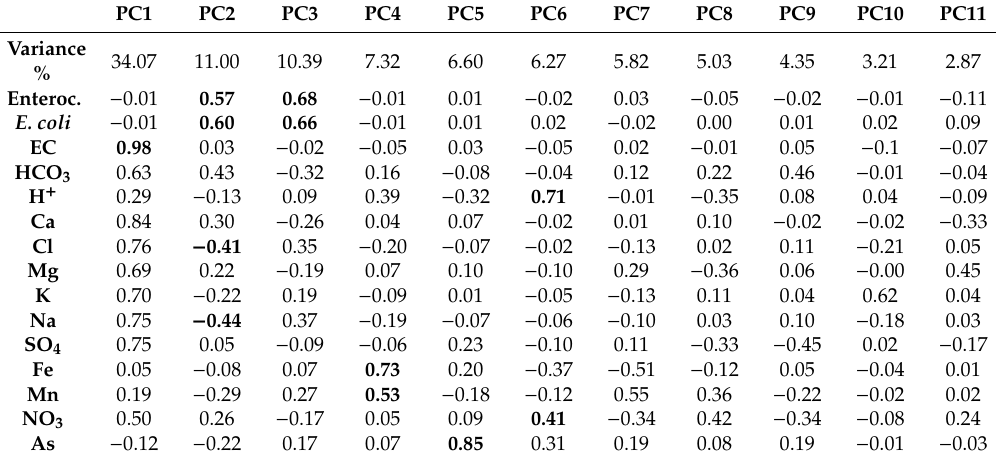
Figure 2. Principal components, eigenvalues, and explained variance from principal component analysis (PCA) performed at the regional scale. Table 1. Principal component analysis performed on regional dataset. Distribution of the variance and coordinates of the variables on first 11 factorial axes. Highest coordinates are in bold.